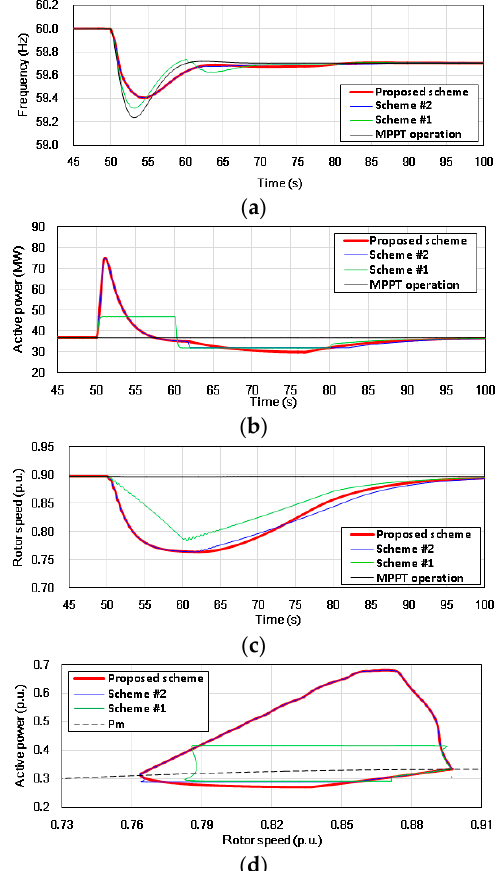
Figure 8. Results for Case 3. ( a ) system frequencies; ( b ) WPP outputs; ( c ) Rotor speeds; ( d ) Power-speed trajectories.